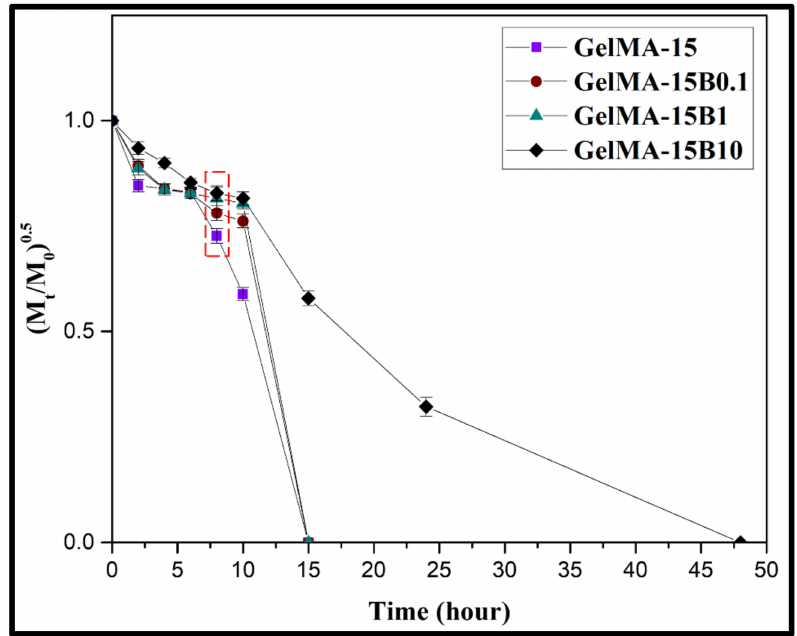
Figure 6. Biodegradation characteristics of GelMA-15, GelMA-15B0.1, GelMA-15B1, and GelMA15- B10 induced by treatment with collagenase type II (25 U/mL − 1